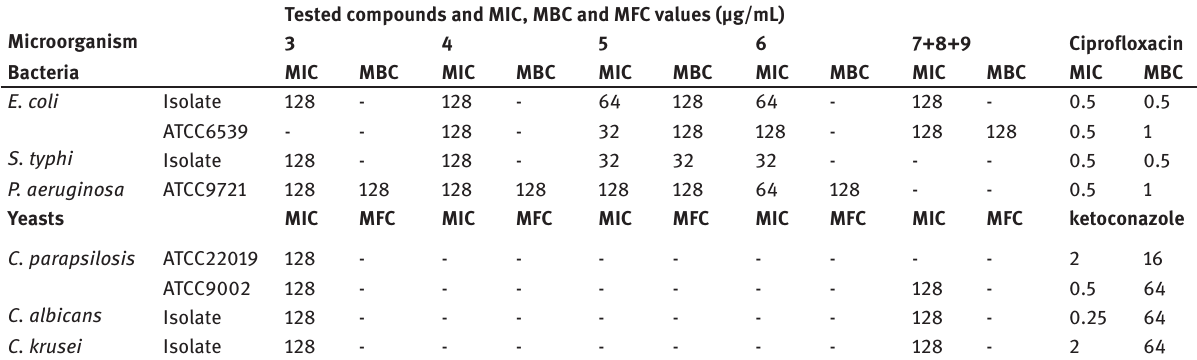
Table 1: MICs, MBCs and MFCs of some isolated compounds. Tested compounds and MIC, MBC and MFC values Microorganism